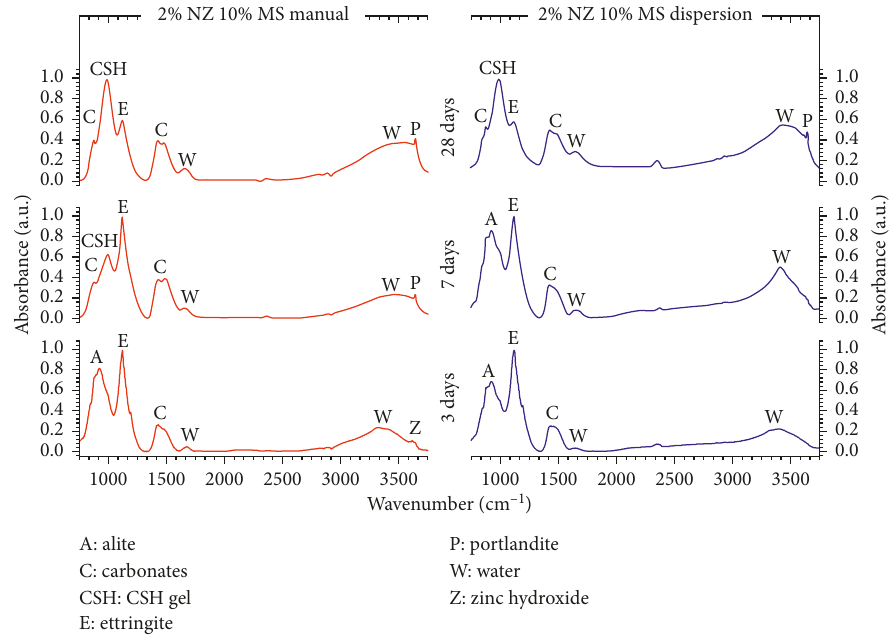
Figure 5: FTIR analysis for cement paste with 2 wt.% of nanozinc (NZ) +10 wt.% microsilica